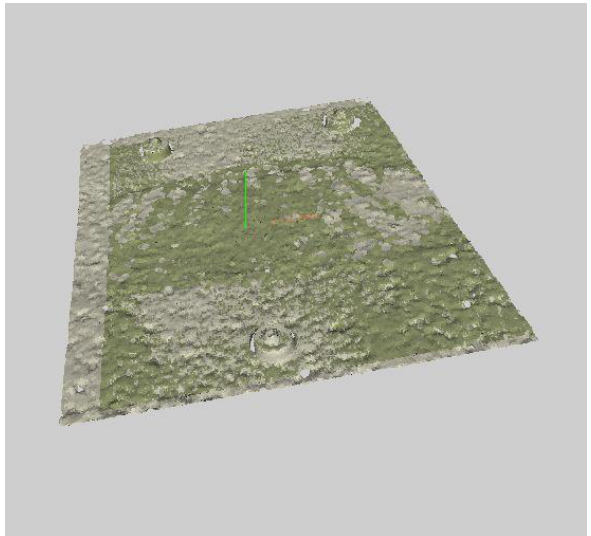
Figure 8. Two scans registration for road pavement behaviour analysis